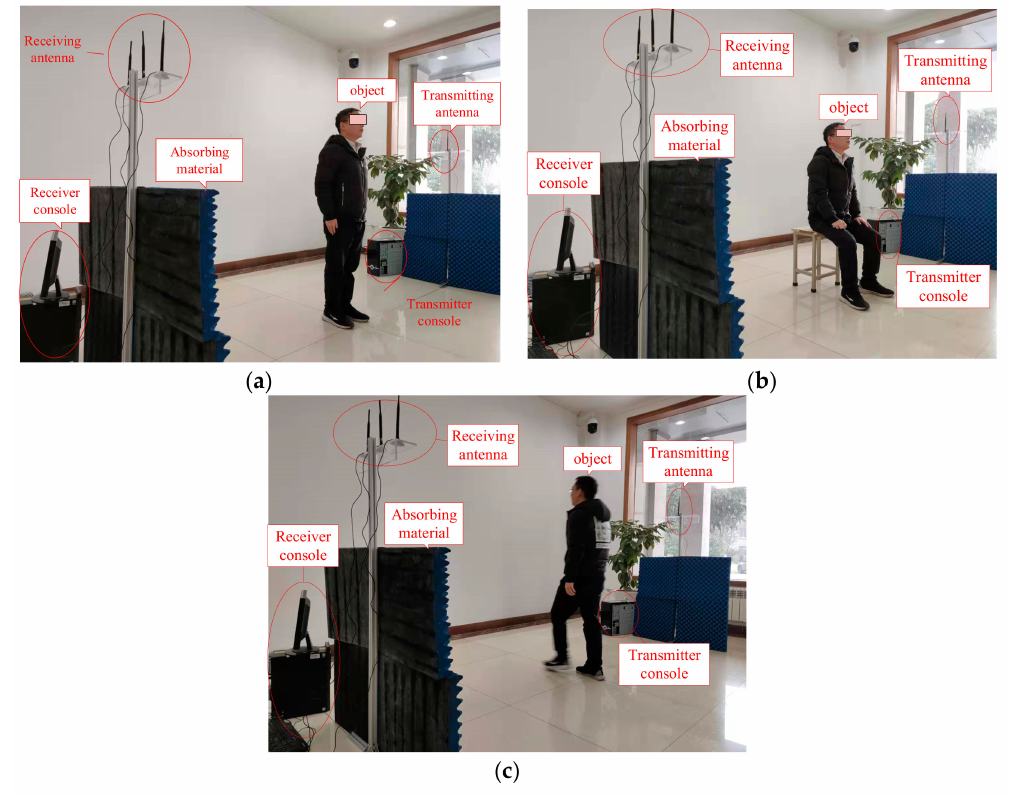
Figure 4. The experimental scene: ( a ) standing; ( b ) sitting; ( c )